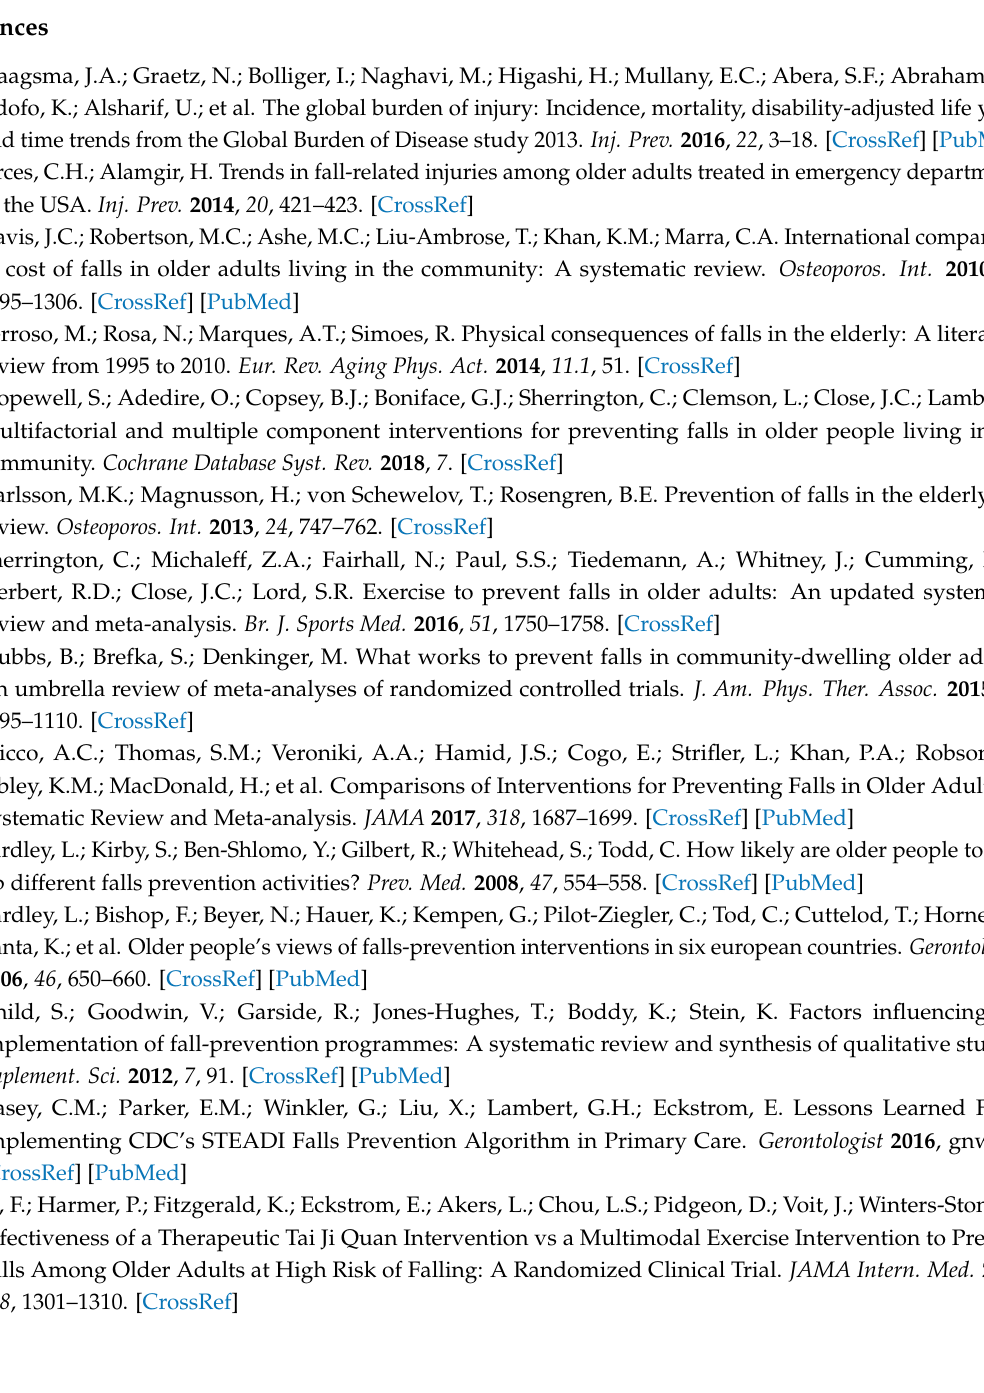
Table S1: Baseline characteristics of older adults that applied for the study, but that did not